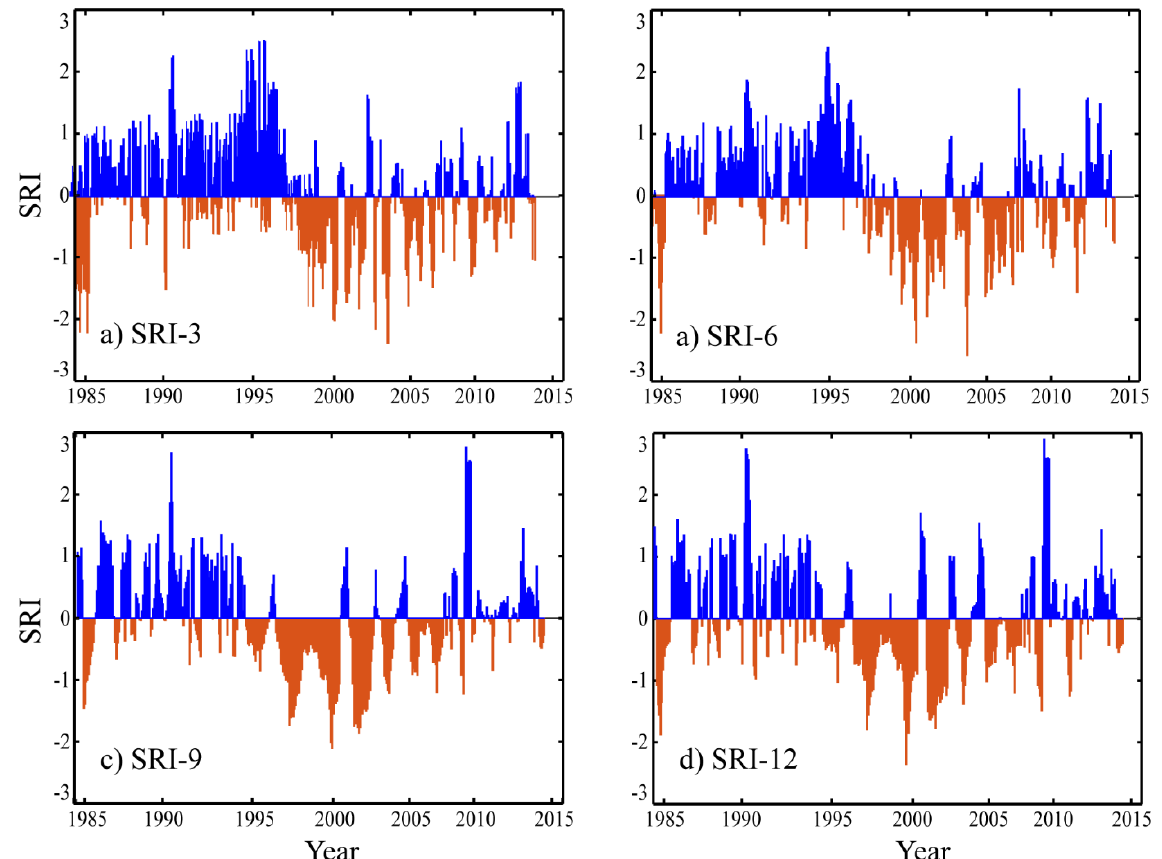
Figure 5. Temporal evolution of the average SRI of the two hydrological monitoring stations in the accumulation periods of ( a ) 3, ( b ) 6, ( c ) 9, and ( d ) 12 months.